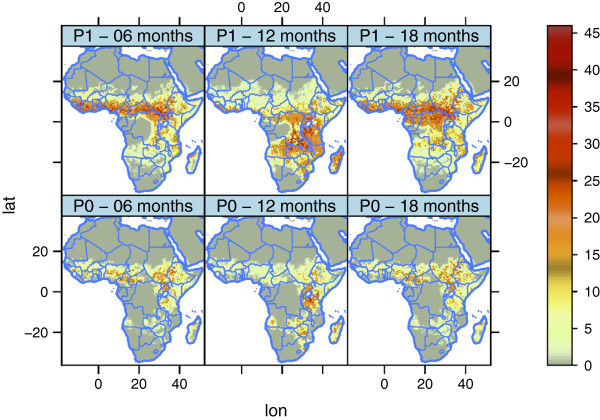
Square root of number ofAn. arabiensis perkm2 in the two pBlood2D experiments. In P0 we used realistic values of the probability of finding blood, P(B), while in P1 the probability of finding blood was set to 1, independent of the location. See the text for further details.